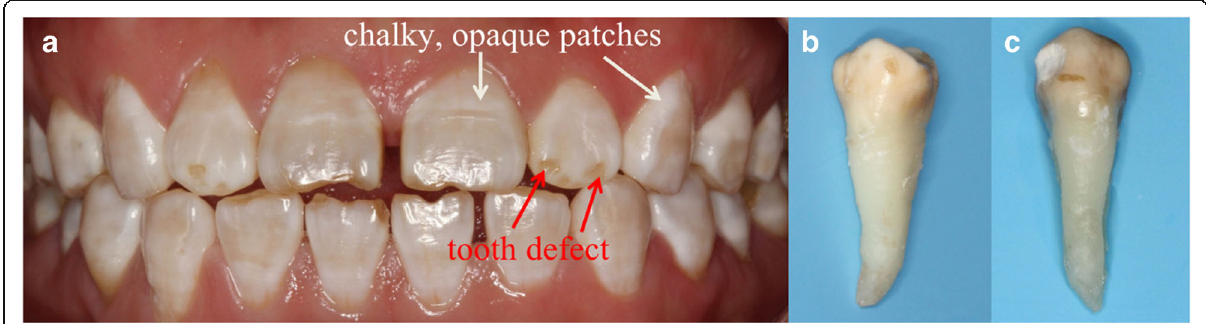
Fig. 1 Photographs of dental fluorosis. a Intraoral photograph of mild dental fluorosis showing chalky, opaque patches and severe dental fluorosis showing both chalky, opaque patches and tooth defects. b Extracted mild dental fluorosis. c Extracted severe dental